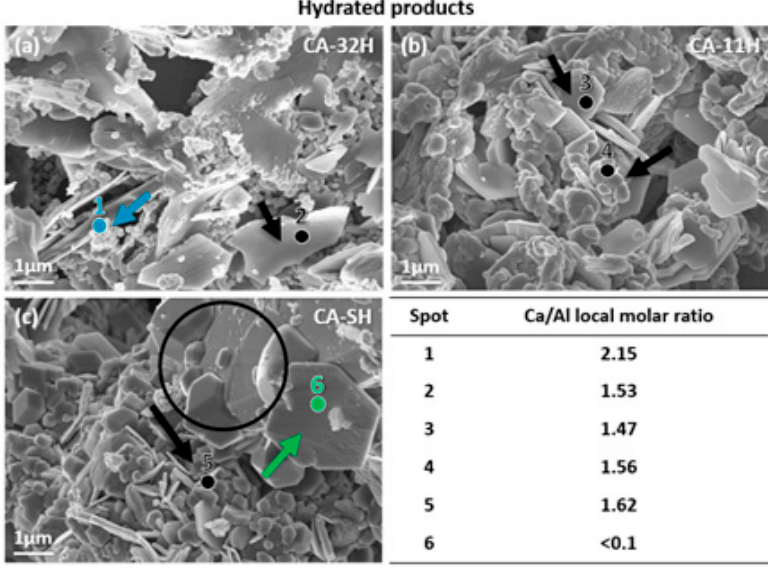
Figure 6. SEM images at magnification = 100 k and punctual energy dispersive X-ray analysis (EDX) estimated Ca/Al molar ratios of hydrated products CA-32H ( a ), CA-11H ( b ) and CA-SH ( c ).